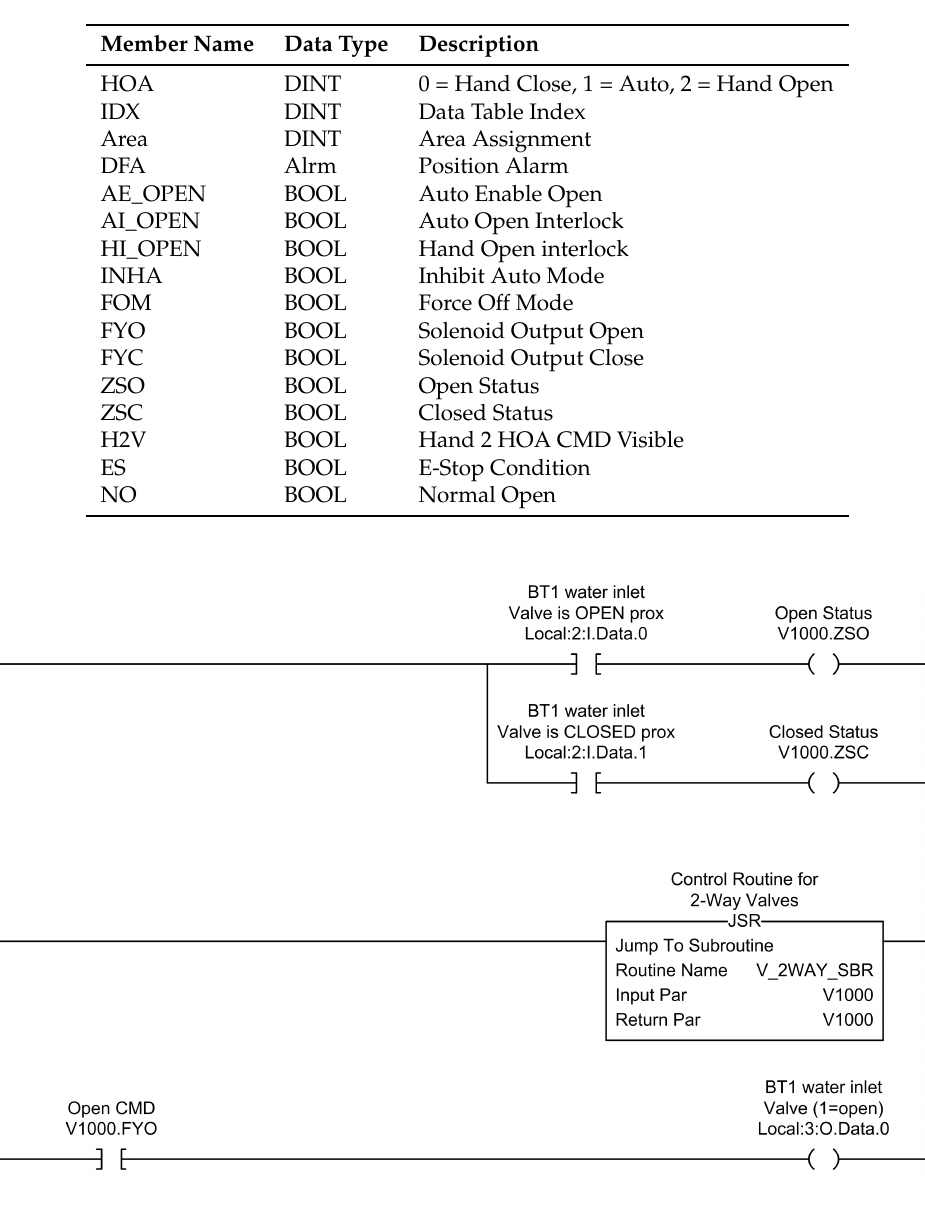
Figure 4. Simplified implementation for control of a two-way valve, original